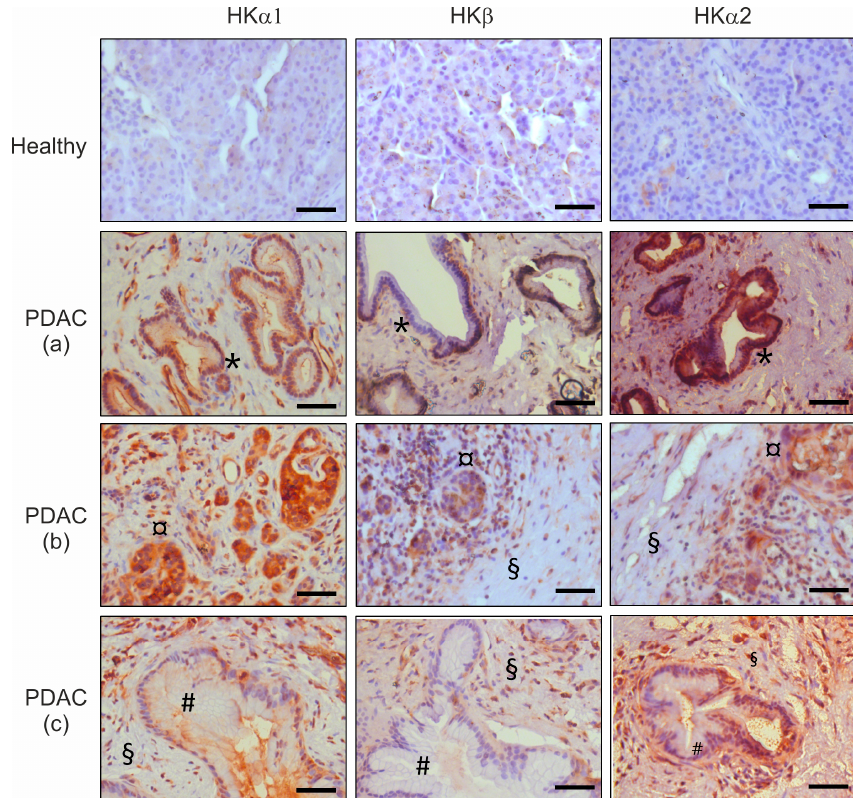
Figure 2. Localization of H + , K + -ATPases subunits in human PDAC. Samples prepared from human pancreatic tissues showing immunohistochemical reaction for HK α 1 stained with Calbiochem 119101 (1:100), HK β stained with Sigma A274 (1:200) and HK α 2 labeled with C384-M79 (1:100). Top panel shows non-cancerous “healthy” tissue. PDAC (a,b,c) panels show different areas of the pancreas where the following can be distinguished: PanIN structures (*), acino-ductal metaplasia (ADM) (¤), mucous cells (#), pancreatic stellate cell (PaSC)-fibrosis (§). Scale bars indicate 30 μ m.